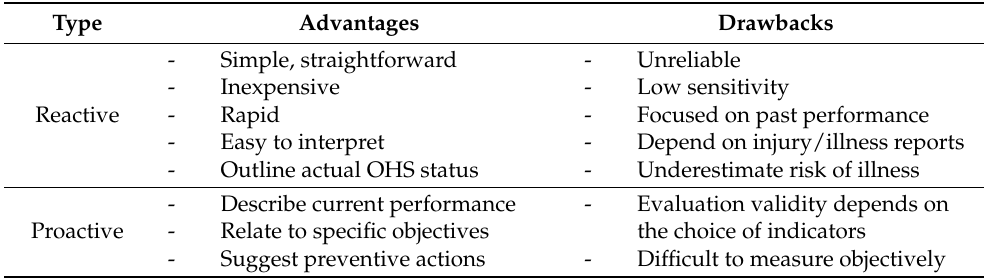
Table 18. Advantages and drawbacks of proactive and reactive indicators of OHS